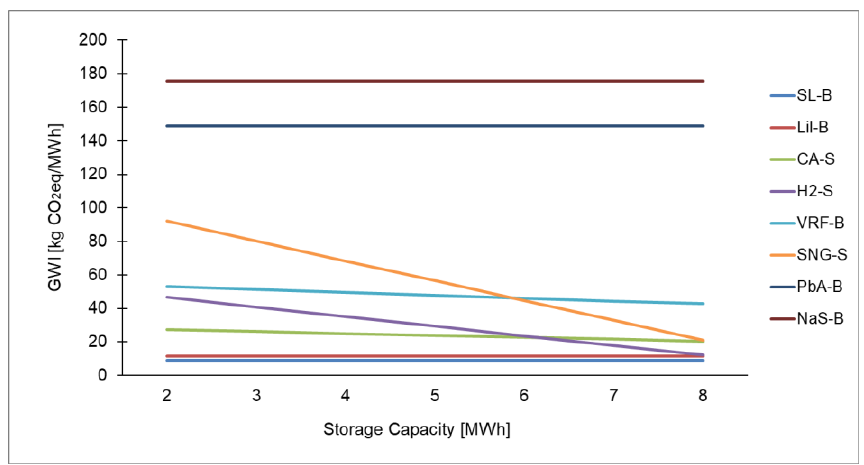
Figure 7. Change in global warming impact GWI per fed-out electricity for increasing the storage capacity of electrical energy storage technologies from 2 to 8 MWh. Energies 2018 , 11 , x FOR PEER REVIEW 11 of 22